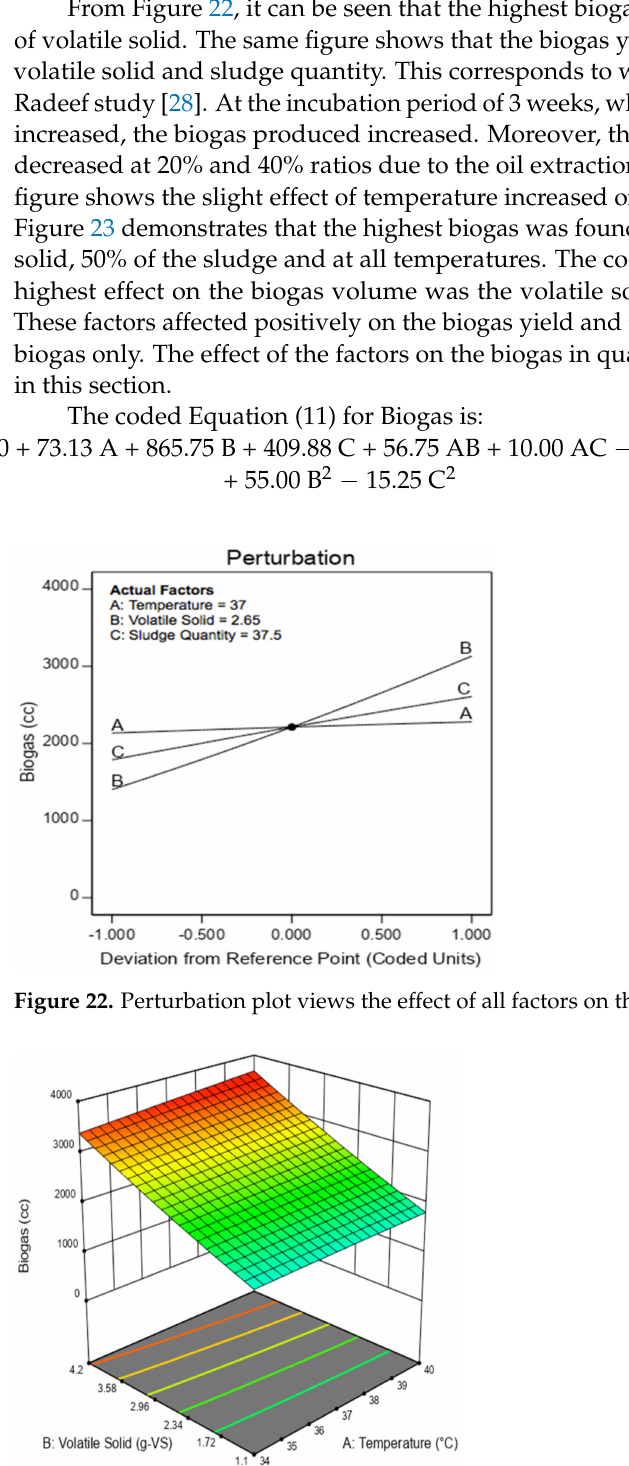
Figure 23. 3-D surface Plot shows the effect of Temperature and Volatile solid on the Biogas yield at sludge quantity of